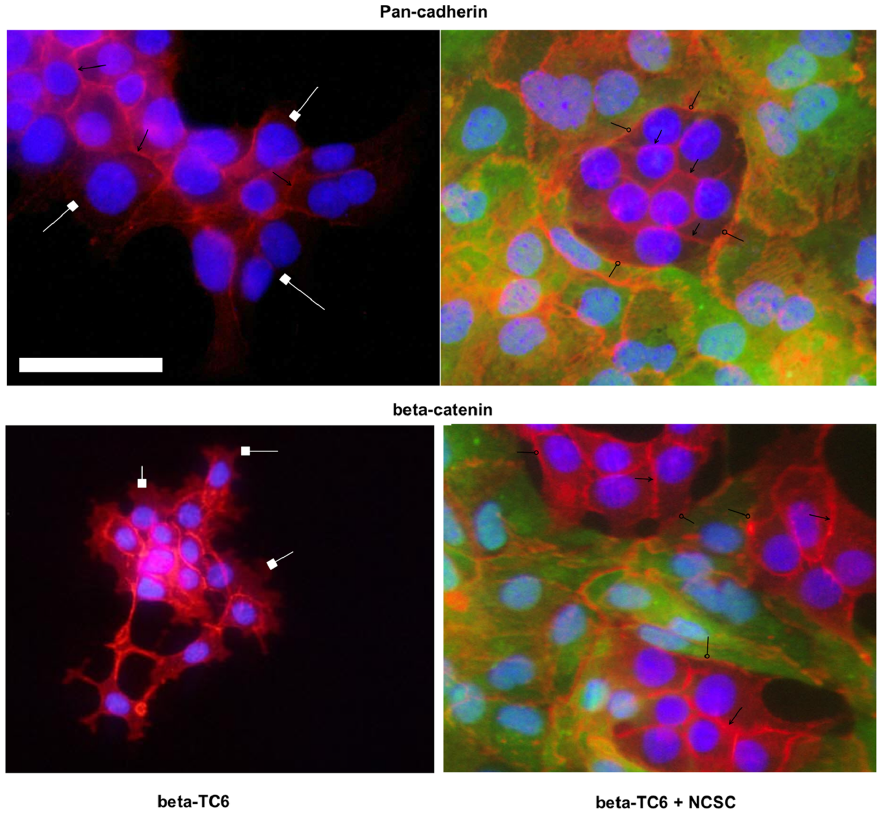
Figure 6. Beta-TC6 cells and NCSCs form cadherin junctions. Non-GFP positive beta-TC6 cells were either cultured alone (left panels) or together with GFP-positive NCSC cells (right panels, green cells) on laminin-coated cover slips. Cells were then fixated, permeabilized and stained for pan-cadherin or beta-catenin (red). Nuclei were visualized by Hoechst. Fluorescence was then photographed in a fluorescence microscope using a 20 6 lens. Arrowheads indicate positions of cadherin/beta-catenin junctions between beta-TC6 cells and circleheads indicate positions of junctions between beta-TC6 cells and NCSCs. Squareheads indicate positions of outer circumference of beta-TC6 not surrounded by NCSCs. The scale bar depicts a distance of 5 m m. Results are representative for three independent experiments.